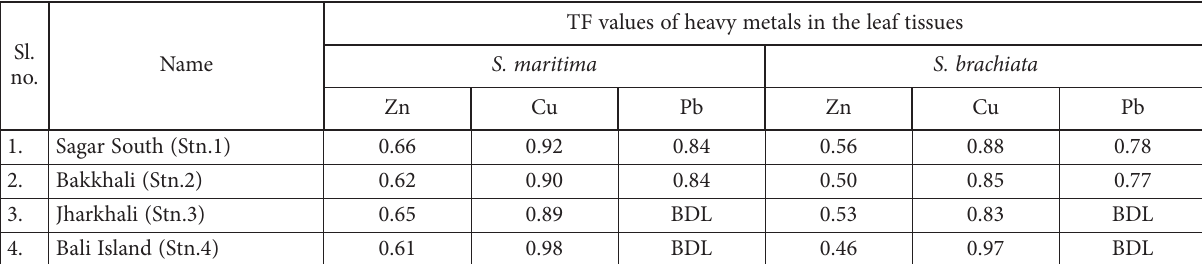
Table 3. Translocation factor (TF) values of heavy metals in the leaf tissues of S. maritima and S. brachiata